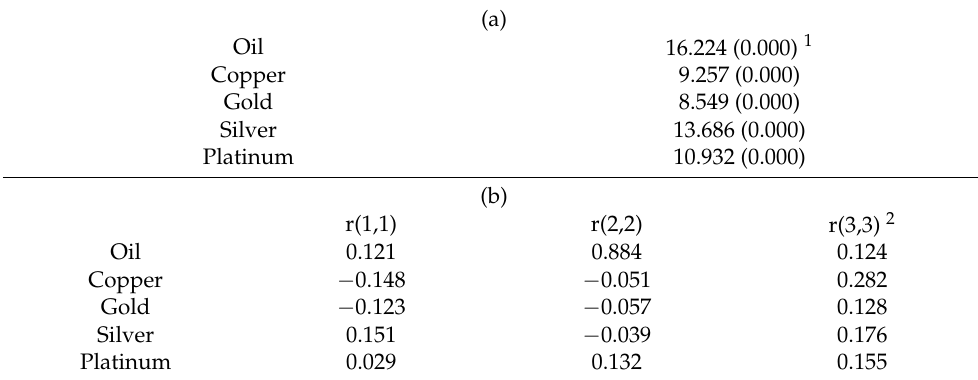
Table 3. (a) Tsay Nonlinearity Test. (b) Hsieh Test